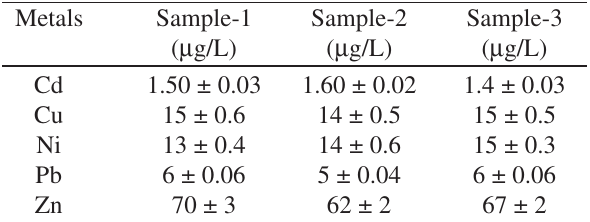
Table 4. Determination of metals in river water samples by GFAAS after photocatalytic digestion of the samples (direct determination, n =